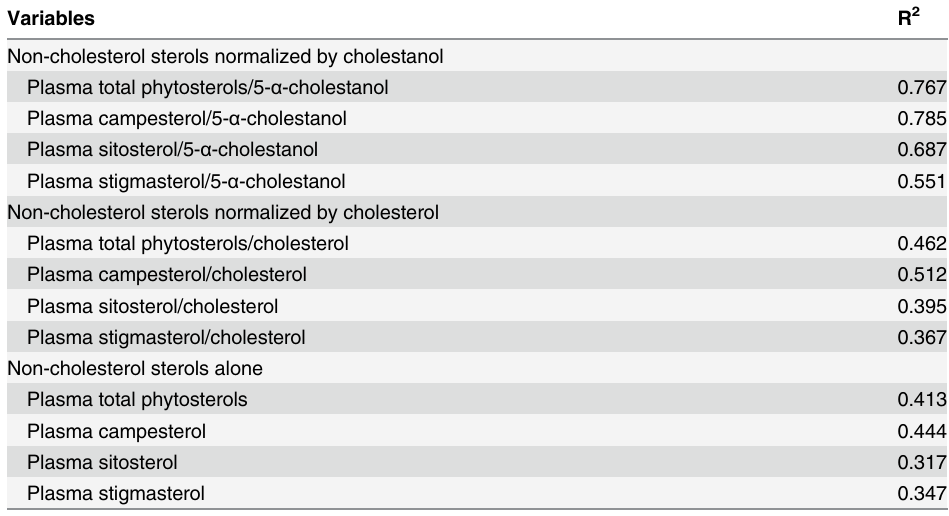
Results are R-squares of simple ordinary least square regression analysis (n = 94 observations), all P <